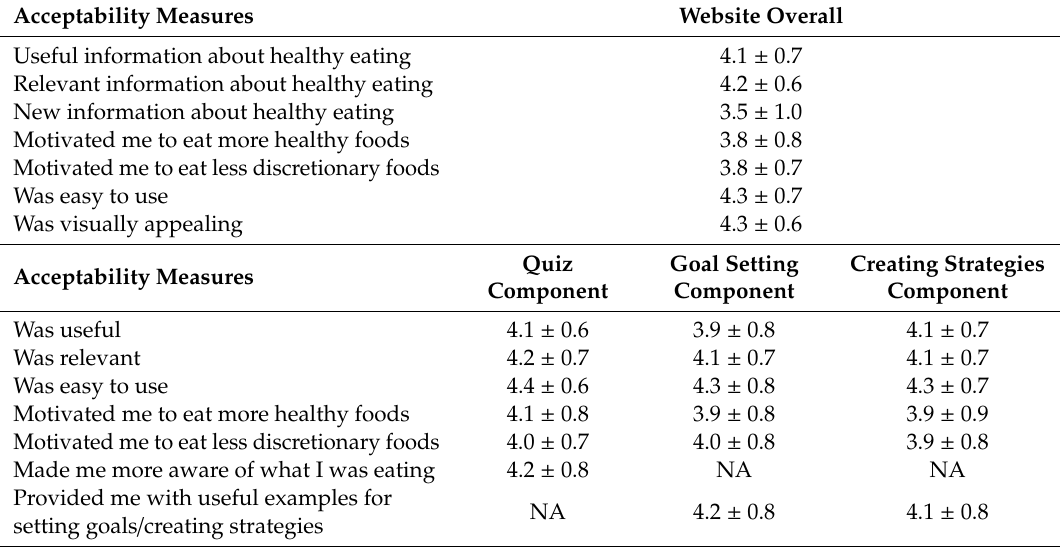
Table 2. Acceptability of the Eating Advice To Students (EATS) brief web-based nutrition intervention components ( N =